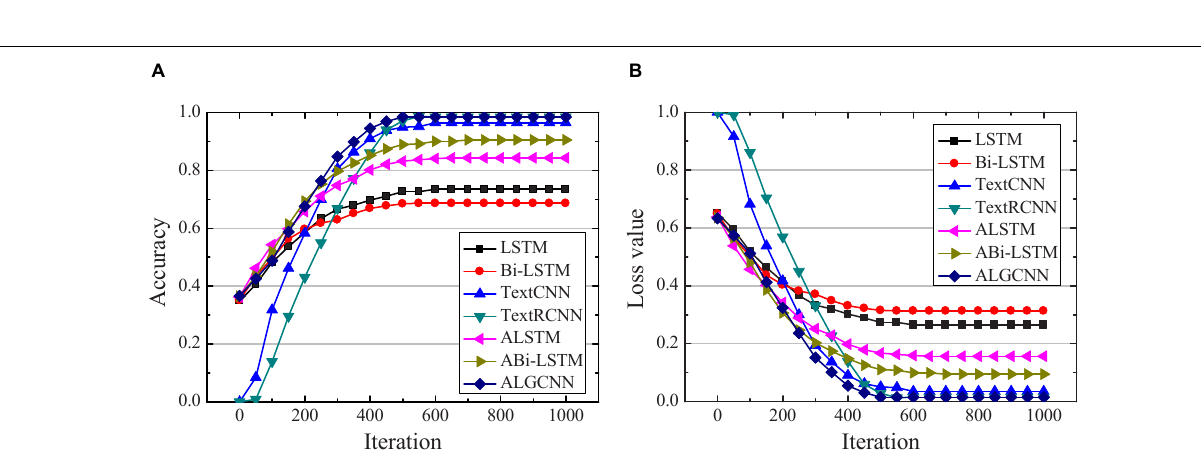
FIGURE 4 | Comparison of classification performance of different models on the SST data set. (A) Is the comparison on classification accuracy; (B) is the comparison of classification loss value.